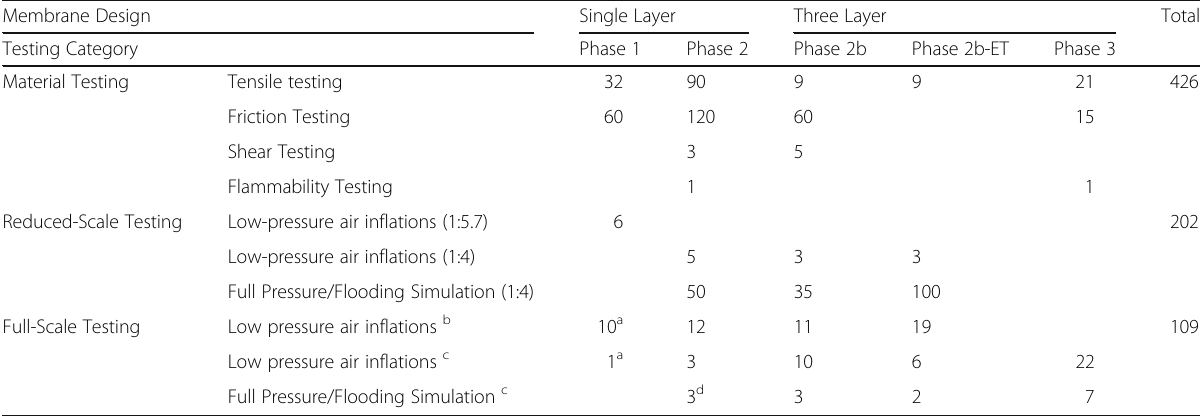
Table 3 Summary of the number of tests per phase and scale of testing Membrane